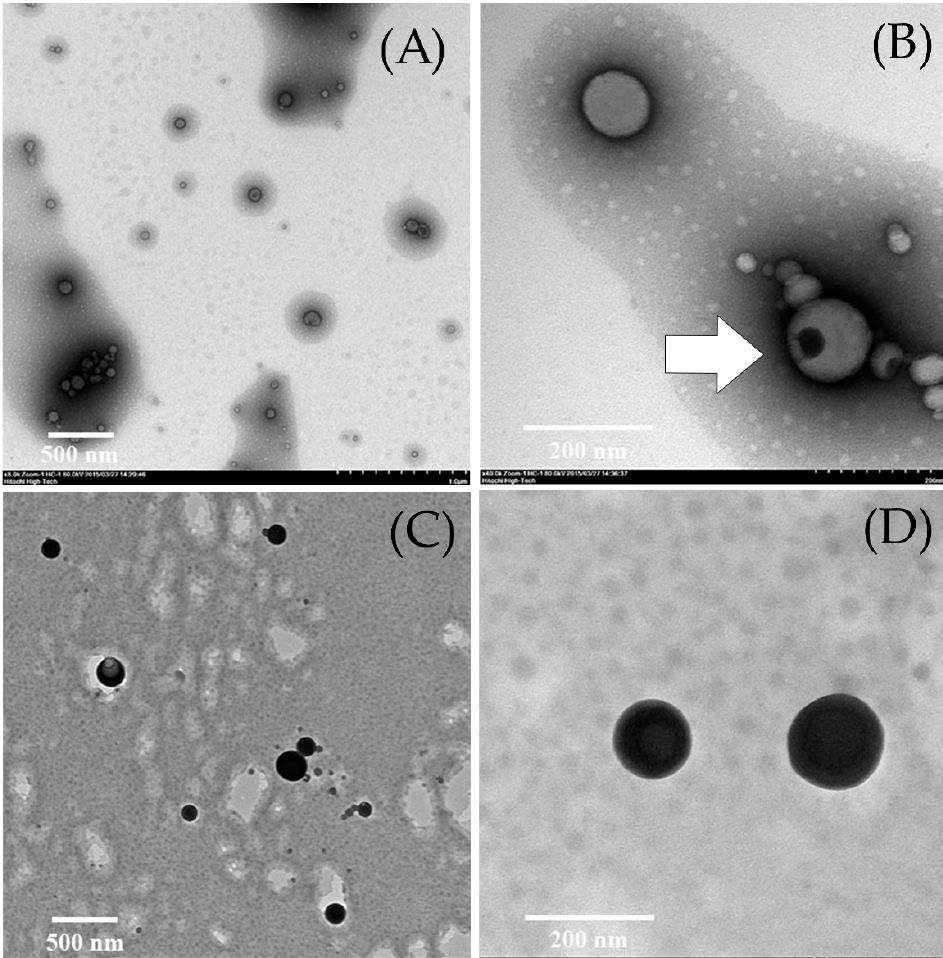
Figure 4. The particle morphology of turmeric rhizome extract nanoparticles of CT OP formulation observed by TEM. ( A , B ) = sample coated with 2% uranyl acetate: 8000× and 40,000×, respectively; ( C , D ) = sample coated with 2% osmium tetroxide: 8000× and 40,000×, respectively.